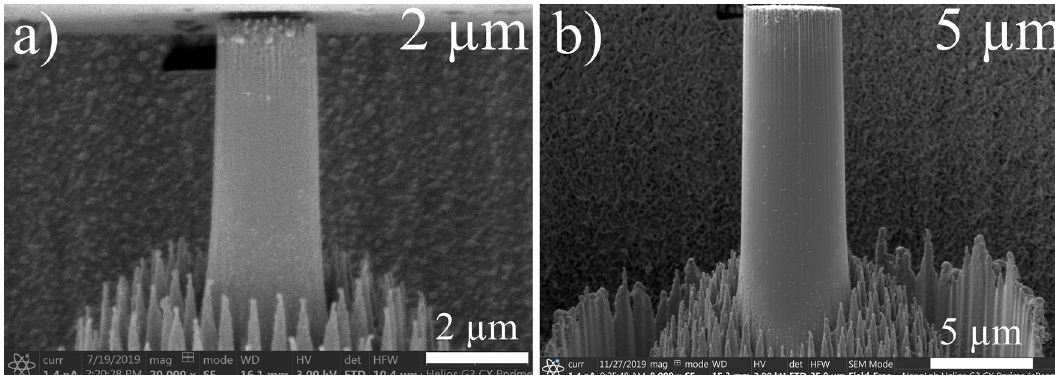
Figure 1. InSb micro-pillars before deformation taken with an observation angle (tilt) of −